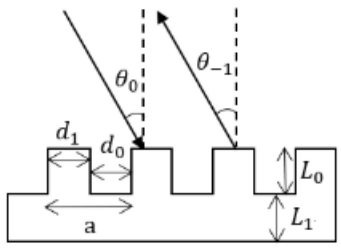
Figure 29. Acoustic metamaterial for ultrasound cloaking [93].